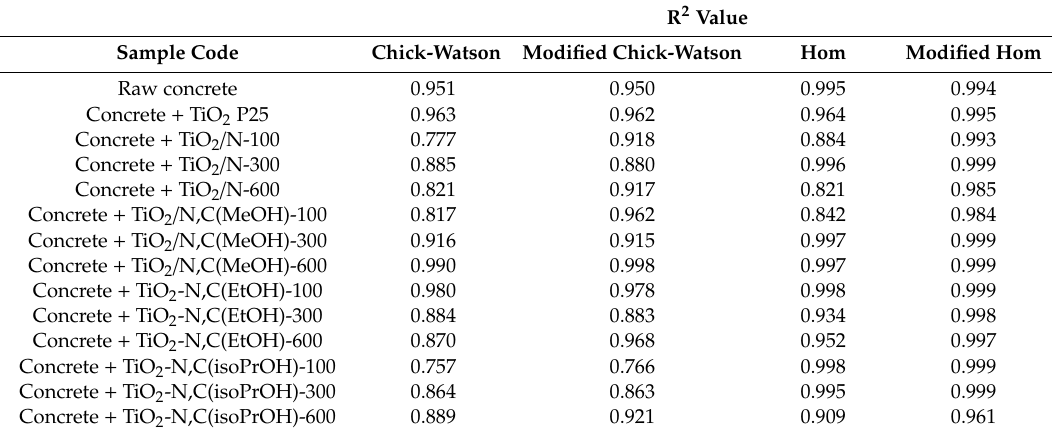
Table 4. R 2 value obtained from the kinetic analyses of tested